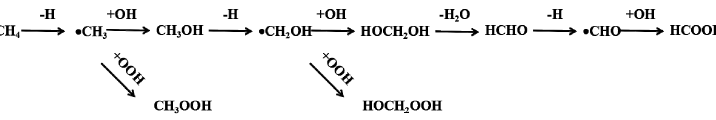
Figure 3. The possible reaction pathways for methane oxidation processes.